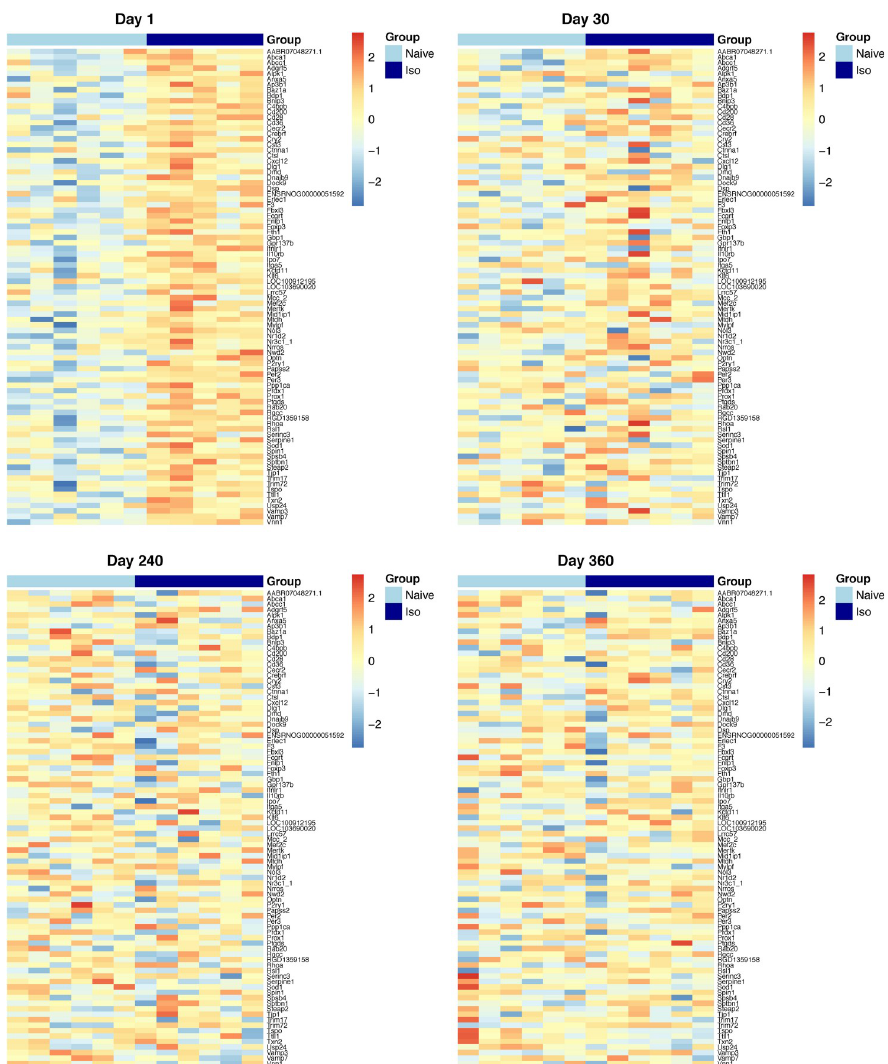
Fig 8. Heatmaps of the 87 “up” genes reflecting short-term effects of repeated acute ISO exposures. Heatmaps generated for the 87 up-regulated genes which were either in wound-related pathways with a p < 0.05 at Day 1, or having a p < 0.1 and changing in the same direction at both Day 1 and Day 30. Top left shows Day 1, top right shows Day 30, bottom left shows Day 240, and bottom right shows Day 360. The light blue represents samples from the na ï ve group; dark blue represents samples from the ISO group. Groups of rats exposed to air (na ï ve, n = 6/each timepoint group) or ISO (n = 5/Day 1 group, and n = 6/Day 30, 240, and 360 groups) were used.